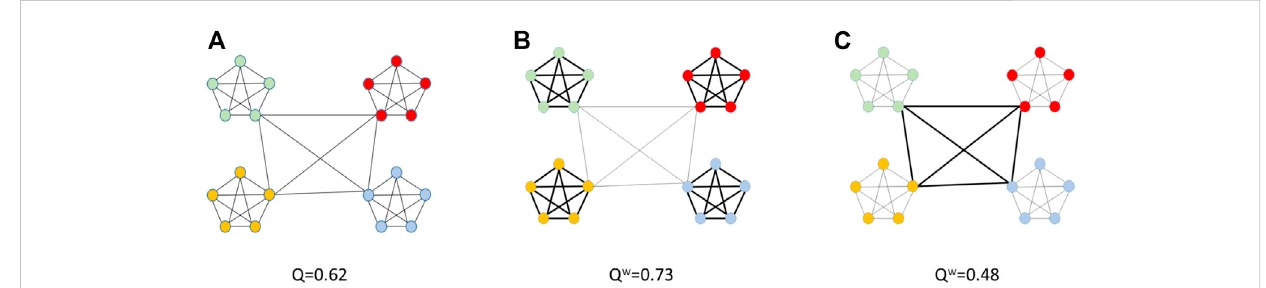
FIGURE 8 Community structure in weighted networks. (A) A binary network of N = 20 nodes and L = 46 links with a strong community structure (node color distinguishesnodesbelongingtothesamecommunity);thisnetworkiscomposedoffourclearlyseparatedcommunities,and Q (cid:2) 0 . 68. (B) Theweighted network counterpart of the binary network in ( A) in which strong links (higher link weights) are inside the communities with Q w (cid:2) 0 . 73. (C) The weighted network counterpart of the binary network in ( A) in which strong links (higher link weights) are outside the communities, and for this network, Q w (cid:2) 0 . 48. The total link weights are the same for networks in (B, C)